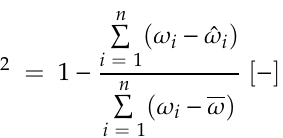
Table 4. The results obtained from the process of deriving the experimental data on angular velocity.